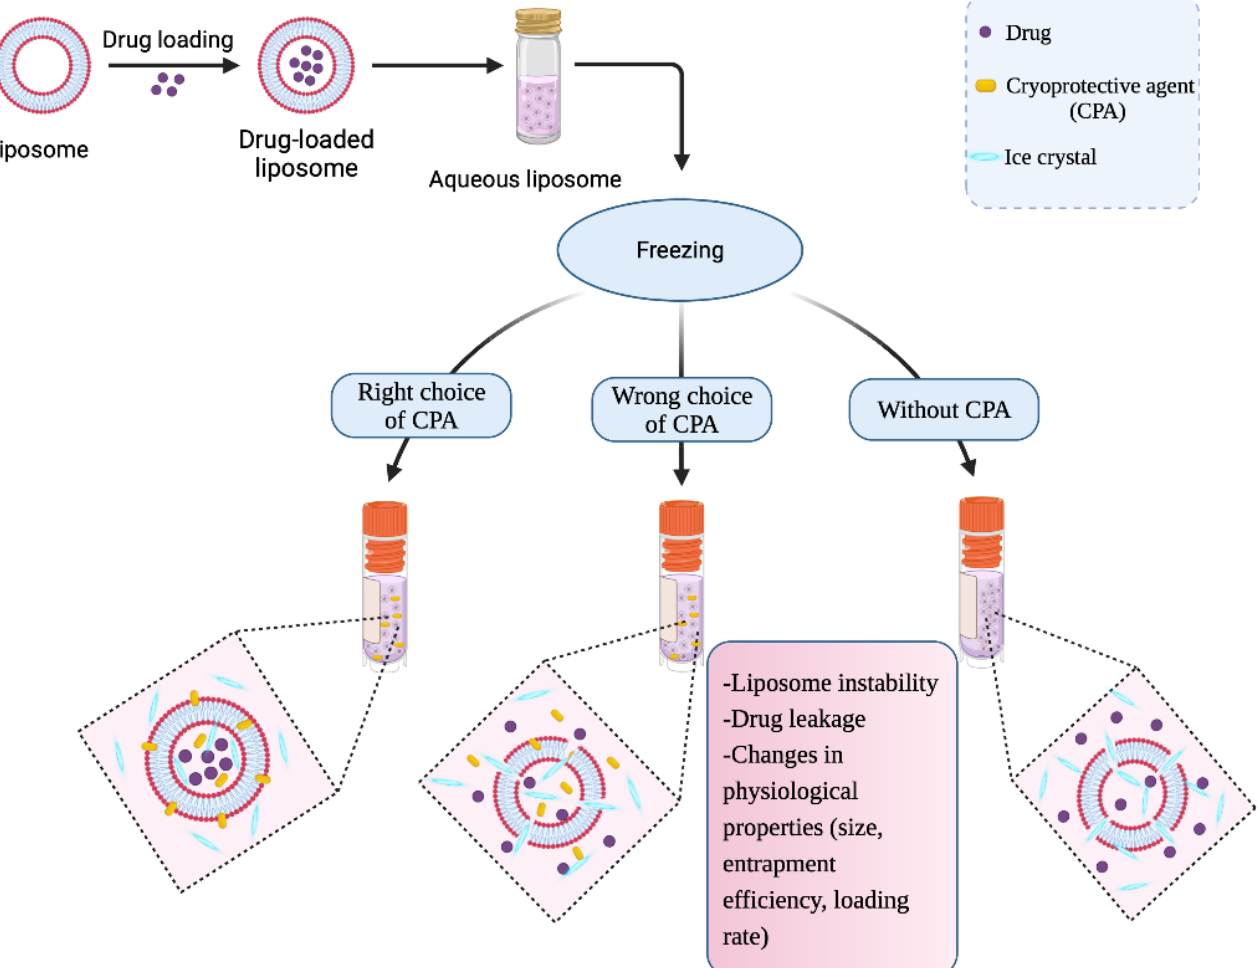
Figure 1. Freezing/lyophilization of drug-loaded liposomes with and without the addition of cryoprotective agents (CPAs).